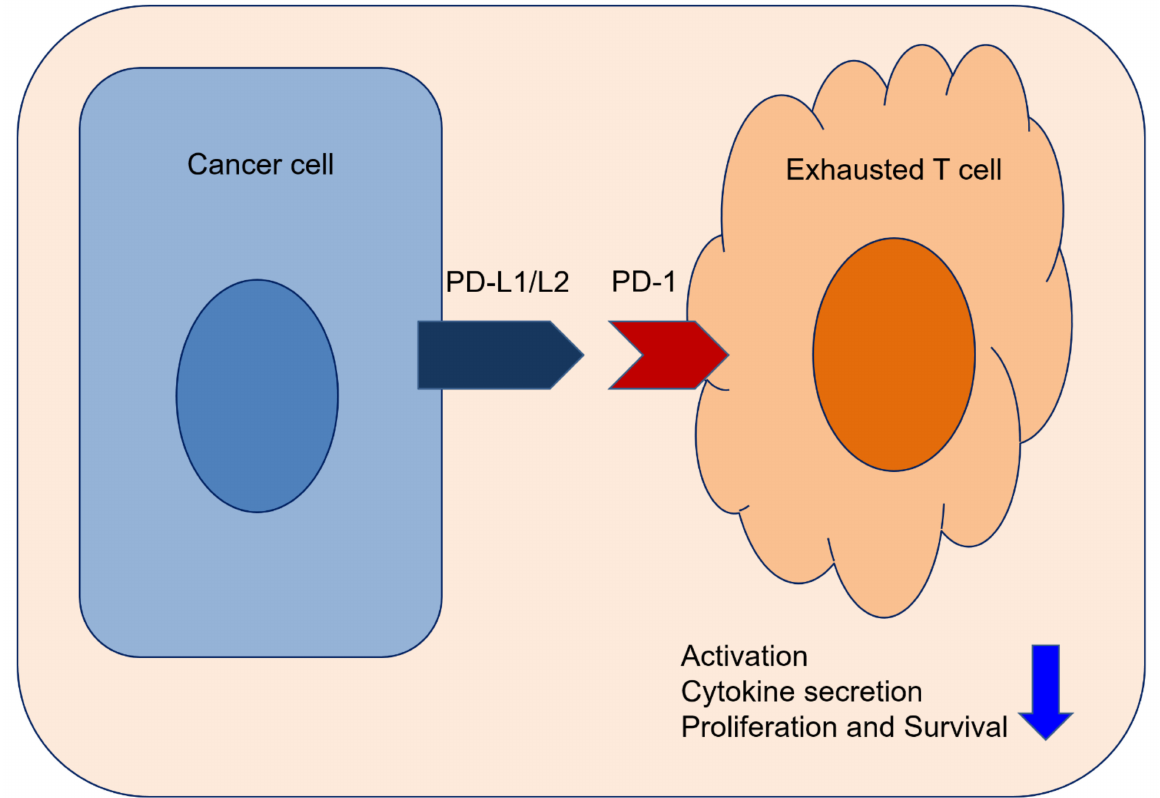
Figure 2. PD-1 axis exhausted T cell leading to immune